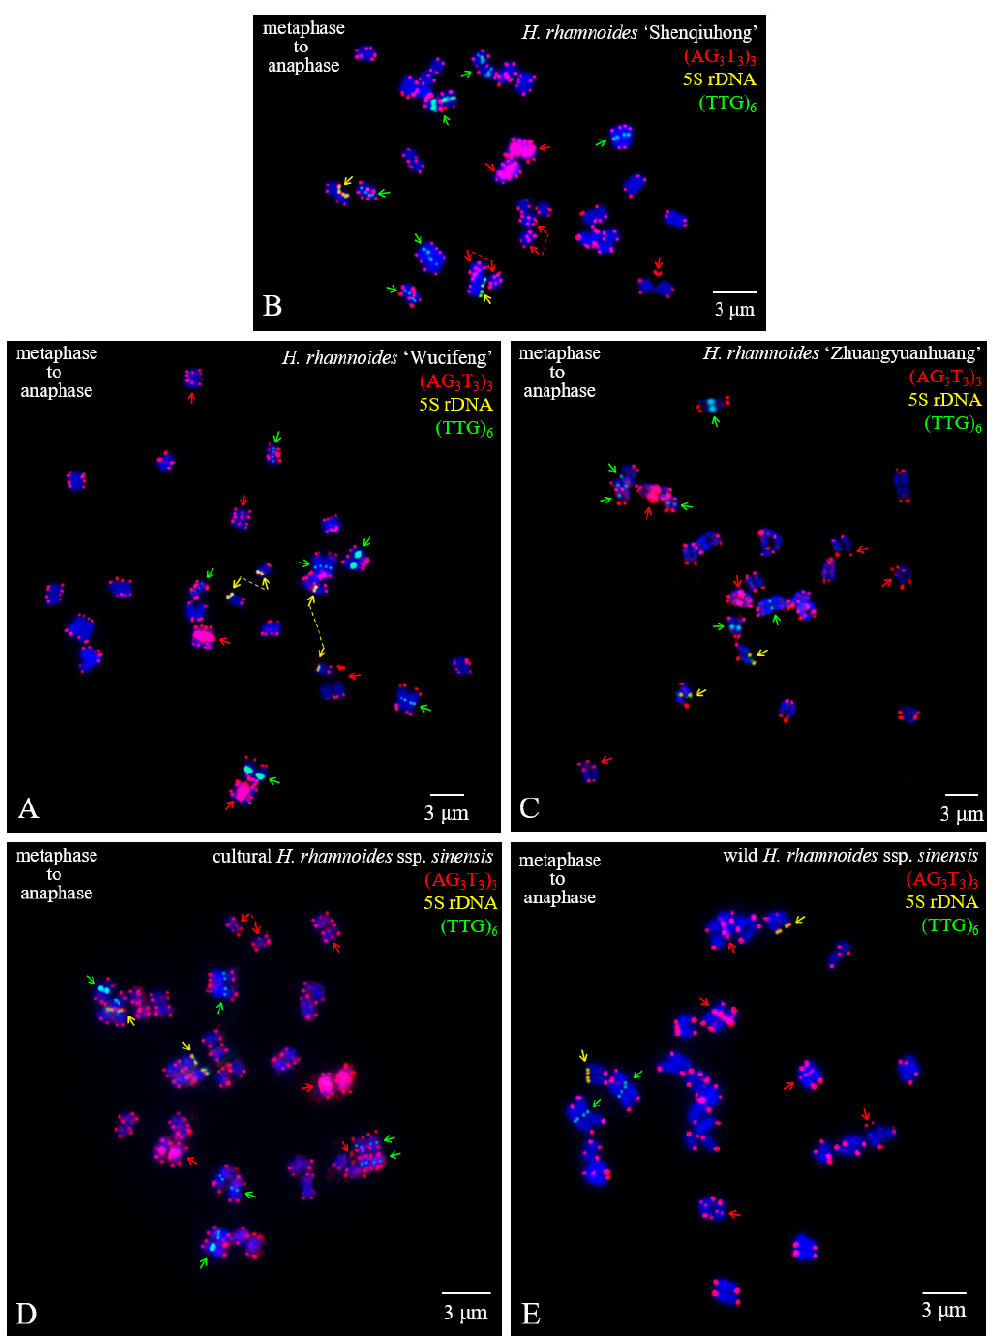
Figure 3. Mitotic metaphase to anaphase chromosomes of Hippophaë rhamnoides detected using (AG 3 T 3 ) 3 (red), 5S rDNA (yellow), and (TTG) 6 (green). ( A ) Hippophaë rhamnoides ‘Wucifeng’, ( B ) H. rhamnoides ‘Shenqiuhong’, ( C ) H. rhamnoides ‘Zhuangyuanhuang’, ( D ) cultural H. rhamnoides ssp. sinensis, and ( E ) wild H. rhamnoides ssp. sinensis . Red arrows show (AG 3 T 3 ) 3 located at the interstitial region of chromosomes or telomere region far away from the chromosome end, whereas yellow arrows show 5S rDNA and green arrows show (TTG) 6 . (AG 3 T 3 ) 3 located at the chromosome end has not been indicated with an arrow. Dotted lines connecting arrows represent two chromo- somes split from one chromosome. We did not annotate all split chromosomes; we only annotated 4 chromosomes in Figure 3A (yellow dotted line), 4 chromosomes in Figure 3B (red dotted line), and 2 chromosomes in Figure 3D (red dotted line). The blue chromosomes were counterstained by DAPI. Scale bar = 3 µ